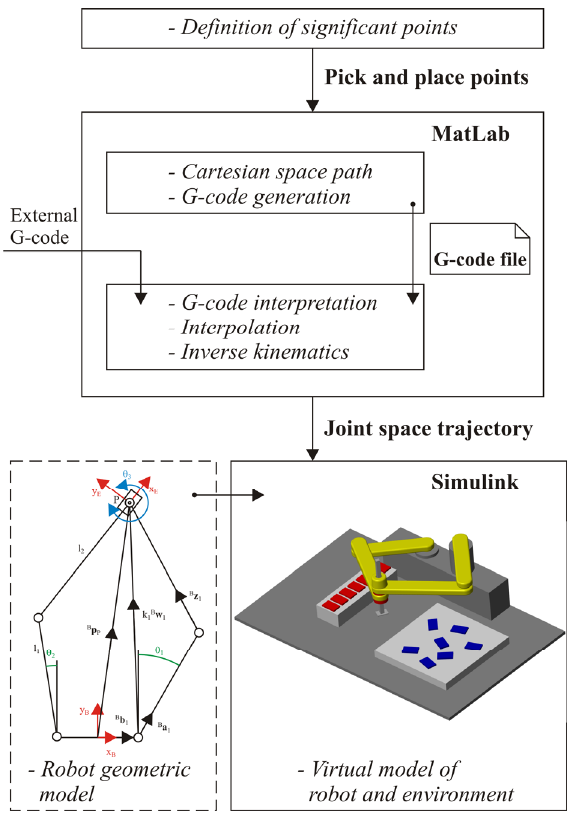
Figure 1. Developed system for the robot programming and simulation The commercial PTC Creo software is used [27] in this research. The configuration of a virtual robot is done according to its kinematic structure, including kinematic connections (joints). It is necessary to create a geometric model of a robot to transfer the physical robot structure in the Simscape model, Fig. 1, because of the kinematic chains, the direction of robot joint axes, robot joint limits, reference robot frame, etc. A robot's geometric model can be found in Section 3 in detail.